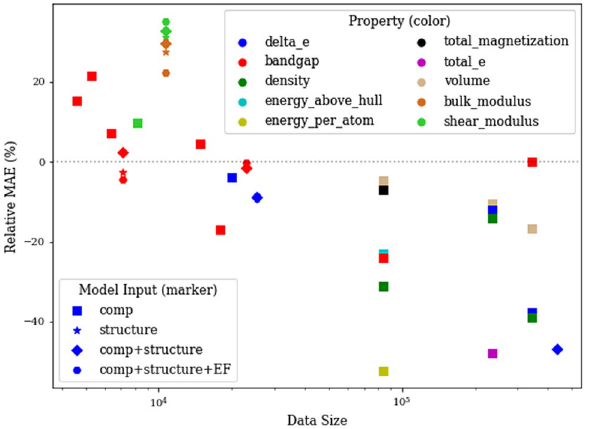
Figure 2. Impact of data size on the performance of IRNet. X-axis shows the dataset size on log scale, and Y-axis shows the percentage change in MAE of IRNet w.r.t. the best traditional ML model (calculated as ( MAE IRNet / MAE BestML − 1 ) × 100% ). We plot the performance of IRNet and best ML model from all the experiment in our study. Note that the reported MAE are on a hold-out test set using a 9:1 random train:test split (same test set is used as validation for OQMD and MP).